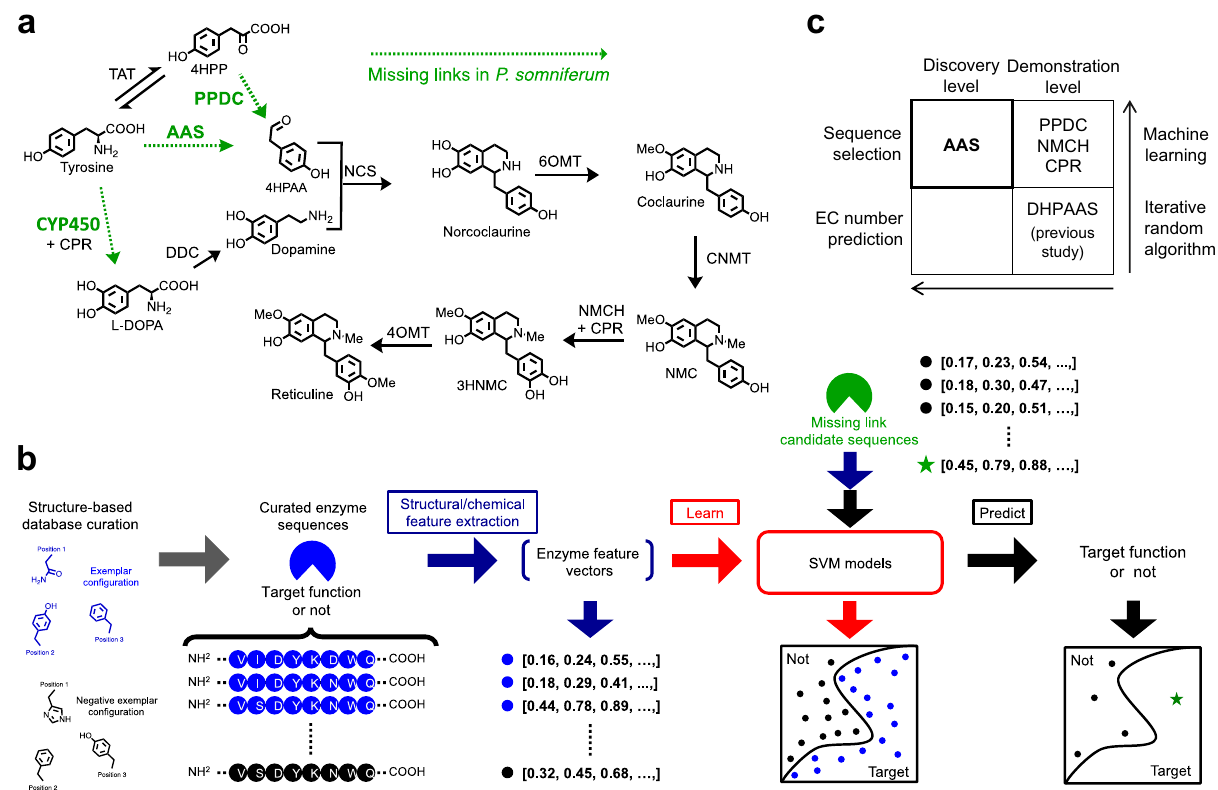
Fig. 1 Uncovering missing links in Papaver somniferum as alternative branches to benzylisoquinoline alkaloids. a Steps mediated by unclear P. somniferum enzymes are shown as green dotted arrows. Steps with black arrows are added to the E. coli chassis by plasmid transformation, except TAT 49 which is naturally present in E. coli as aromatic-amino-acid aminotransferase (tyrB). Metabolite abbreviations: 4HPP 4-hydroxyphenylpyruvic acid, 4HPAA 4-